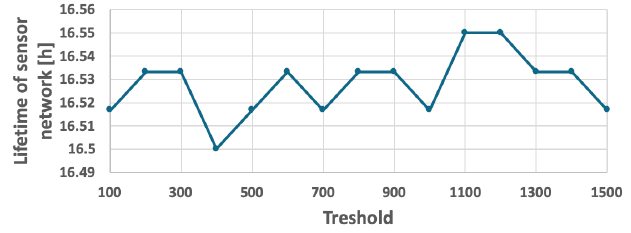
Figure 14. Calibrating the FDCR algorithm for fixed probability of event occurrence.